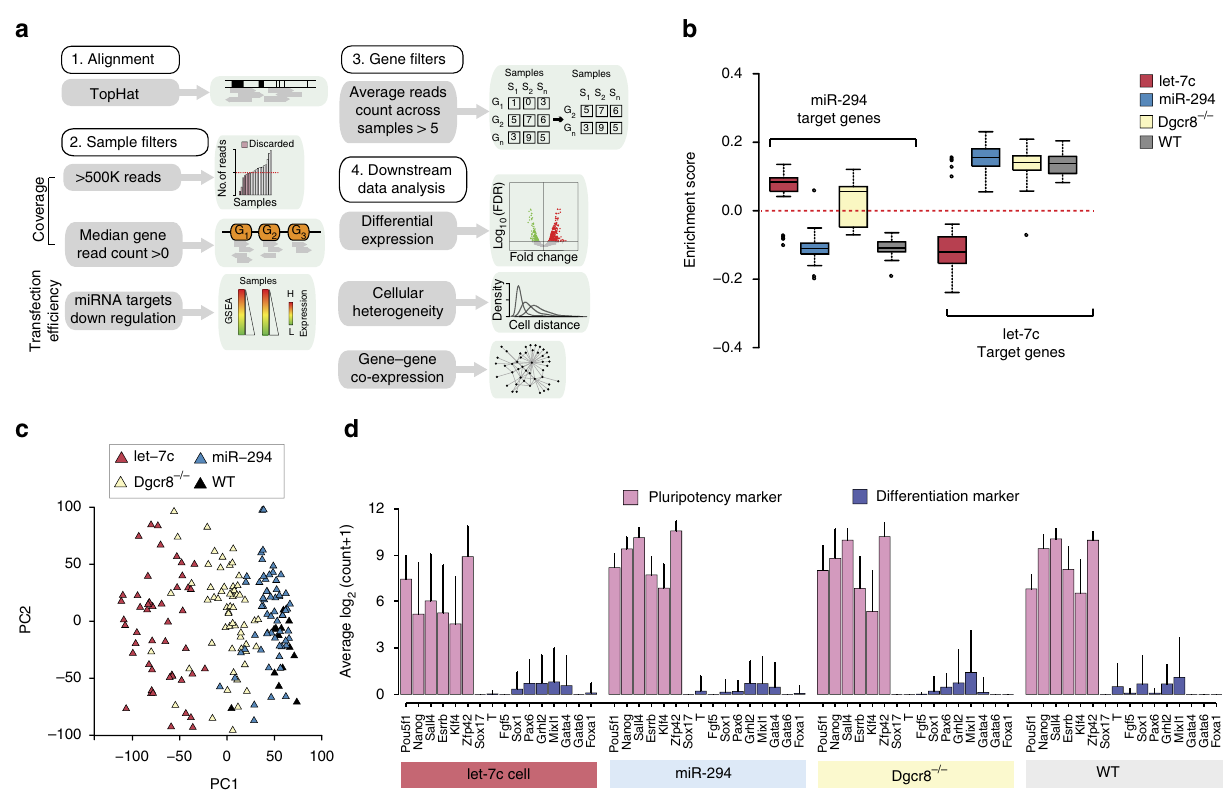
Figure 1 | Single-cell sequencing of mESC transfected with either miR-294 or let-7c. ( a ) Scheme of the bioinformatics and statistical pipeline for single- cell sequence analysis. Briefly, (i) reads are aligned with TopHat software and then (ii) cells with low coverage or with no evidence of miRNA transfection are removed and (iii) finally non-expressed genes are filtered out. Remaining genes are used (iv) for downstream analysis. Details provided in material and methods section. ( b ) ES distribution of miR-294 target genes across miRNA transfected, Dgcr8 (cid:2) / (cid:2) or WT cells. ( c ) PCA analysis on filtered and normalized data showing individual cells colour coded by condition. The PCA analysis separates cells according to their condition. ( d ) Average expression of 16 pluripotency/differentiation markers in each